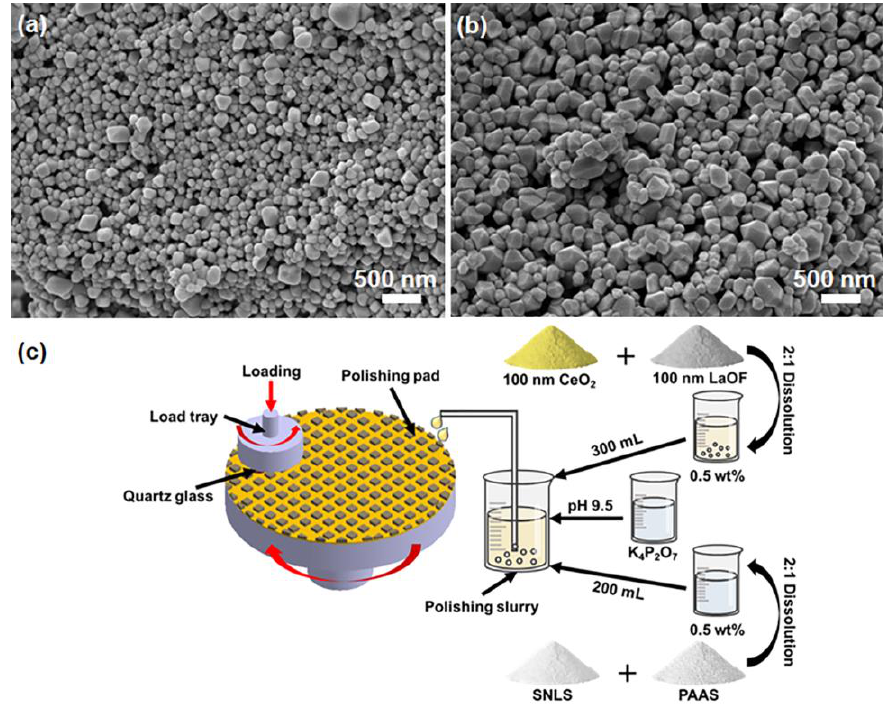
Figure 2. SEM image of ( a ) cerium oxide abrasive; ( b ) lanthanum fluoride oxide abrasive; ( c ) the configuration of the polishing slurry and the polishing process schematic.